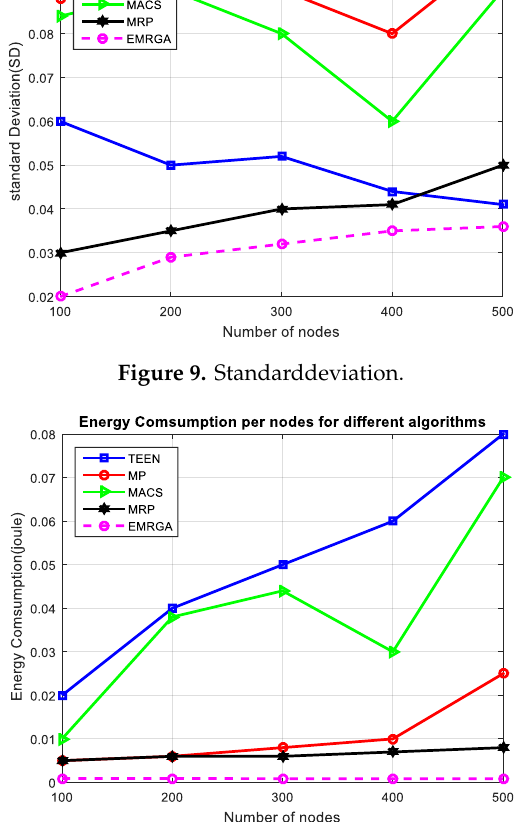
Figure 9. Standarddeviation.